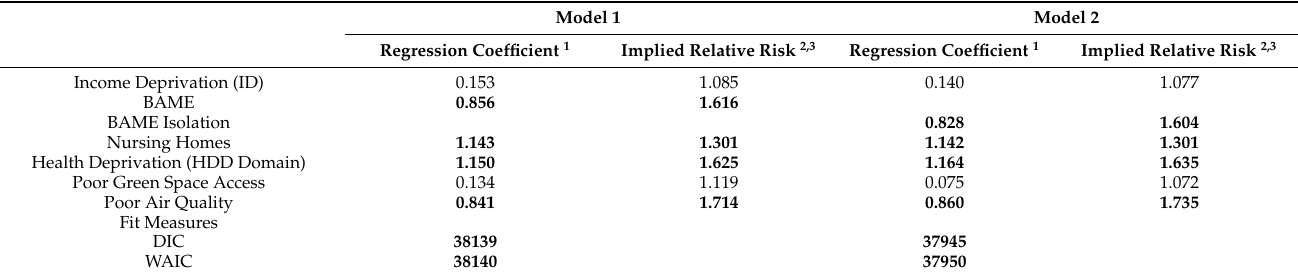
Table 3. Regression Coefficients, Associated Relative Risks and Fit. Two Models Compared. Model 1 Model 2 Regression Coefficient 1 Implied Relative Risk 2,3 Regression Coefficient 1 Implied Relative Risk